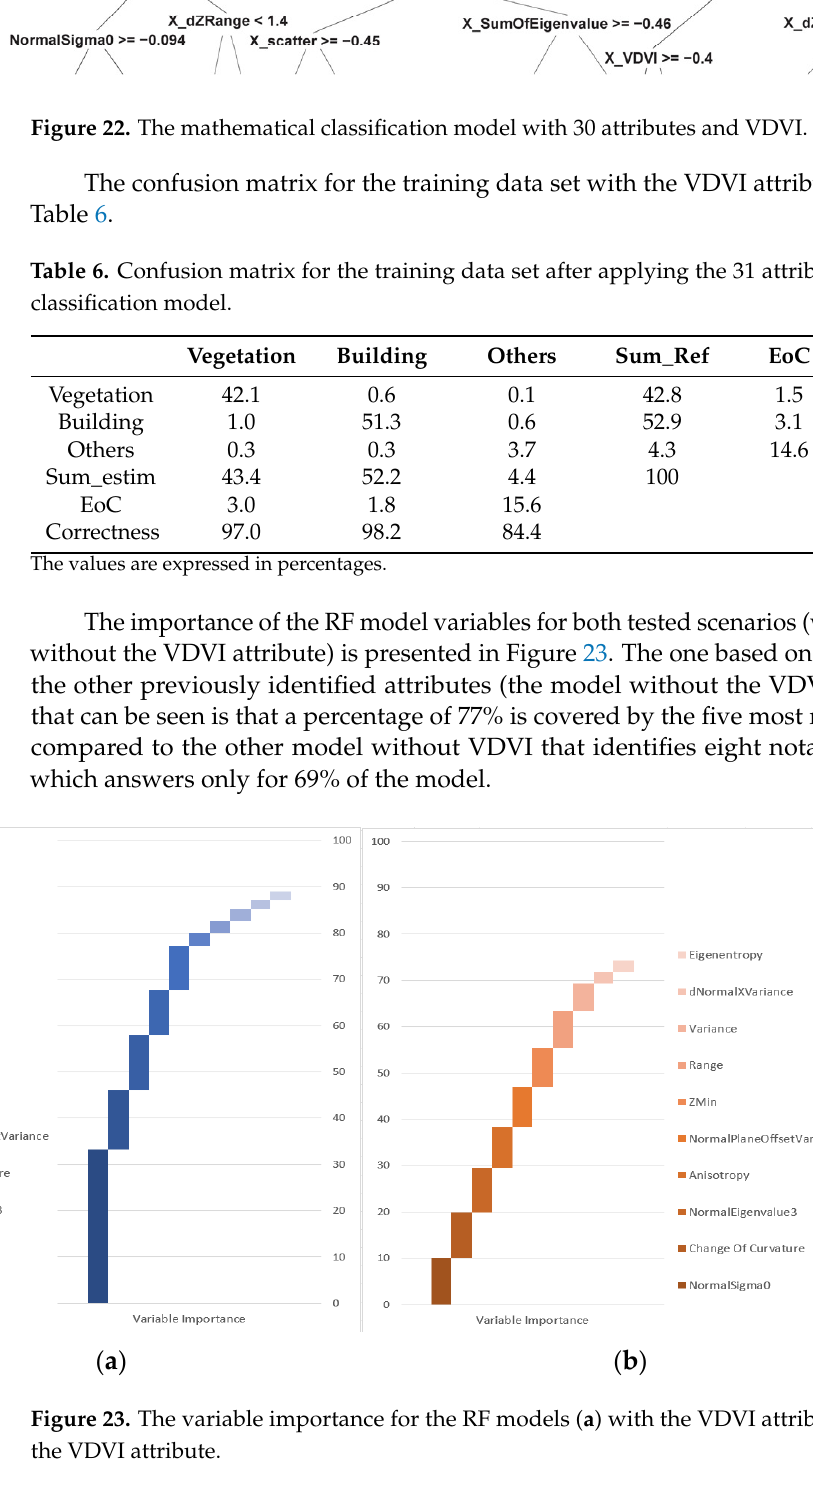
Figure 22. The mathematical classification model with 30 attributes and VDVI.